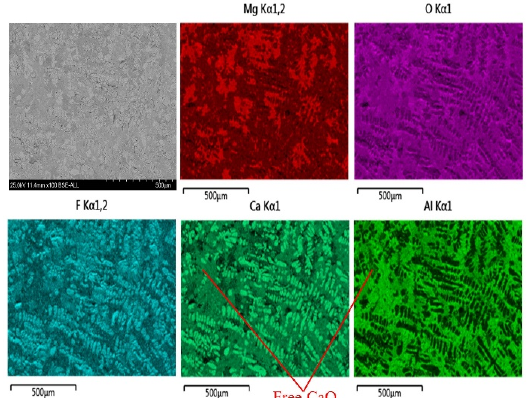
Figure 7. The element distribution diagram of slag T1 analyzed by SEM-EDS.